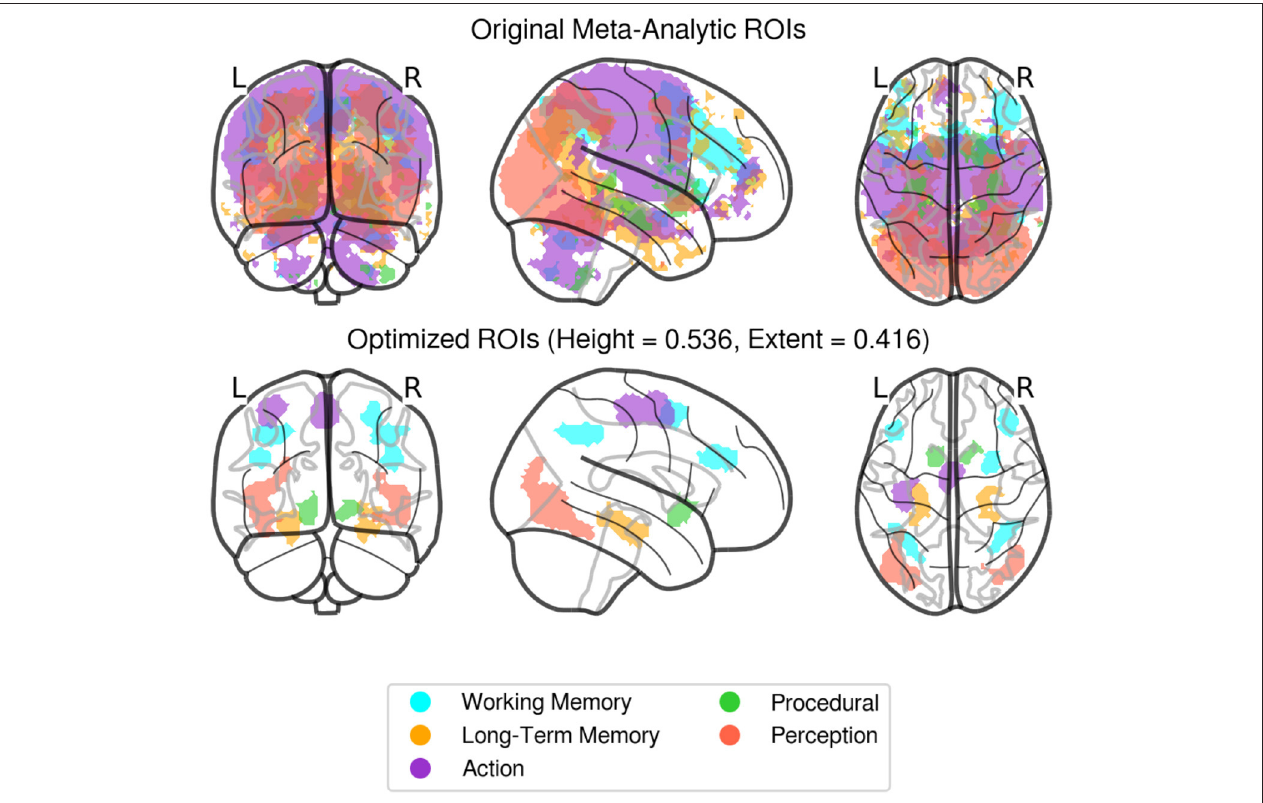
FIGURE 4 | Original (non-thresholded, top ), and Optimized (final, bottom ) regions of interest derived from Neurosynth activity masks. Individualized ROIs were created by identifying voxels responding significantly ( p < 0.05) to any of the waveform regressors, within these predefined areas for each